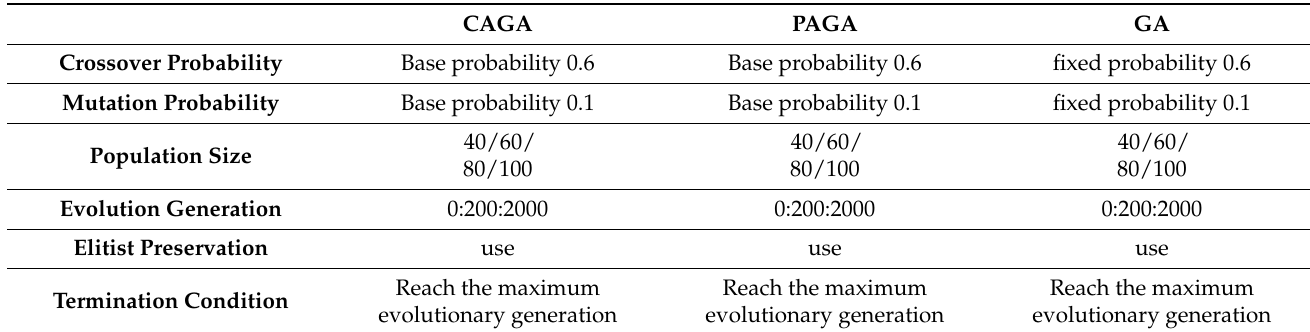
Table 2. Cont. CAGA PAGA GA